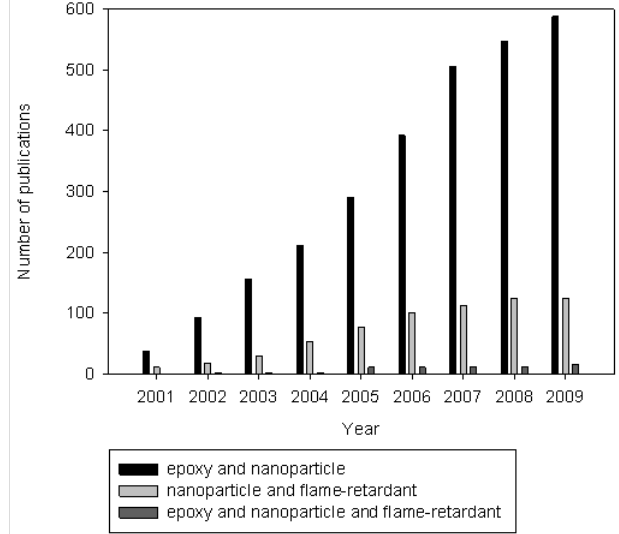
Figure 1. Number of publications per year for different keyword combinations (Scifinder, April